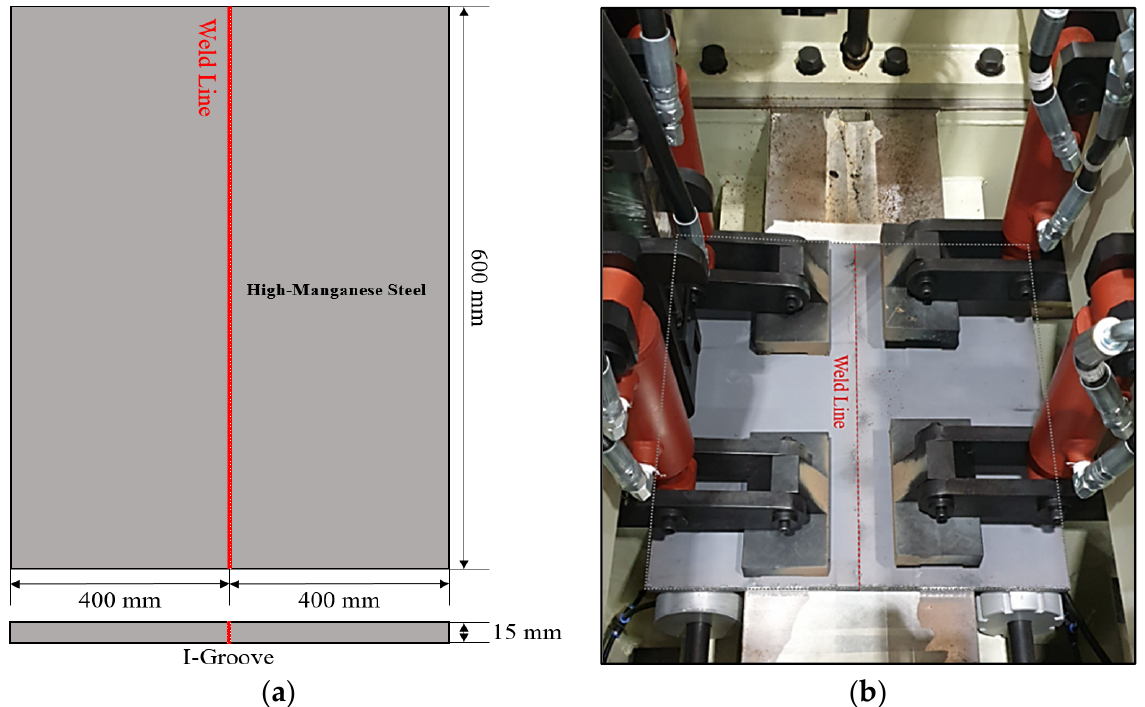
Figure 1. Specifications of the test specimen and the experimental setup of the test specimen. ( a ) Dimension of the test specimen, ( b ) experimental setup of the test specimen.